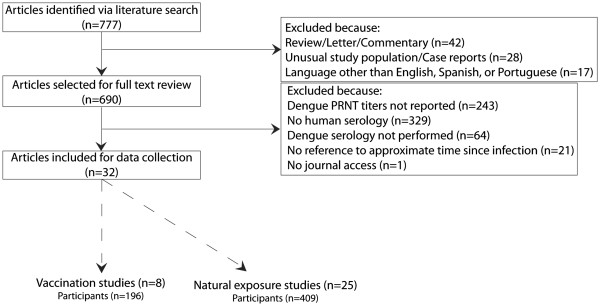
Article selection and inclusion/exclusioncriteria. Articles do not sum to 32 as one report included multiple exposure routes and is included in both exposure categories